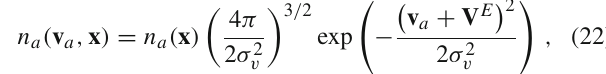
magnetic field, at t mes = 0, the superposition states of neutral atoms separate from each other so that each state (up and down) moves in one of the SG loops. Around t mes = T / 2, the ALP DM interacts with neutral atoms. Then, at t mes = T , the inverse effect of the magnetic field leads to bringing the two states of neutral atoms back together (for more details, see Appendix